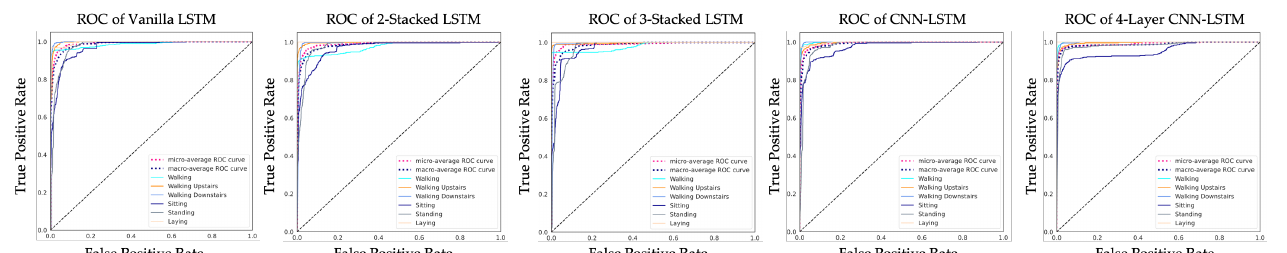
Figure 16. Receiver operating characteristic curves of five LSTM